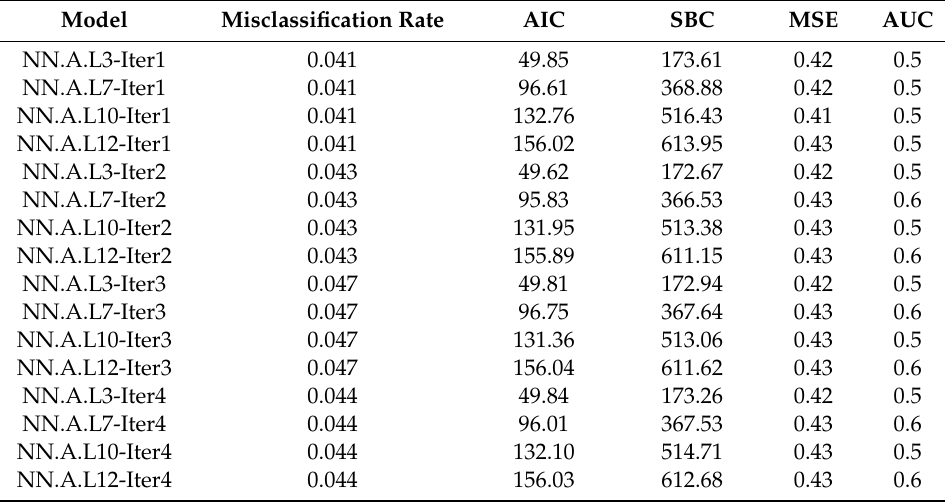
Table 15. First iterations of the training test of the best neural network